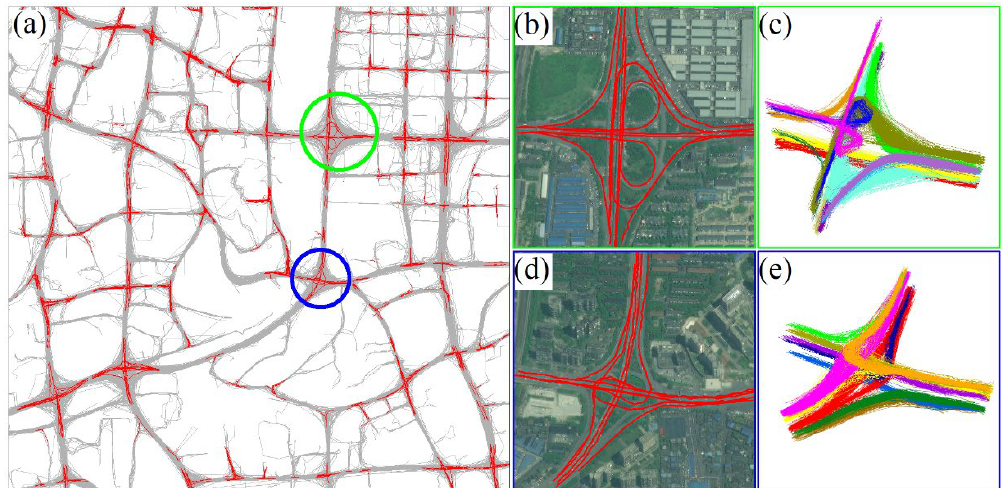
Figure 10. Results of identifying turning modes and extracting structural models of road intersection. ( a ) the structural models of road intersection. ( b – e ) the enlarged views of the generated geo-metric models and extracted turning modes of the two road intersections in the green and blue circles in ( a